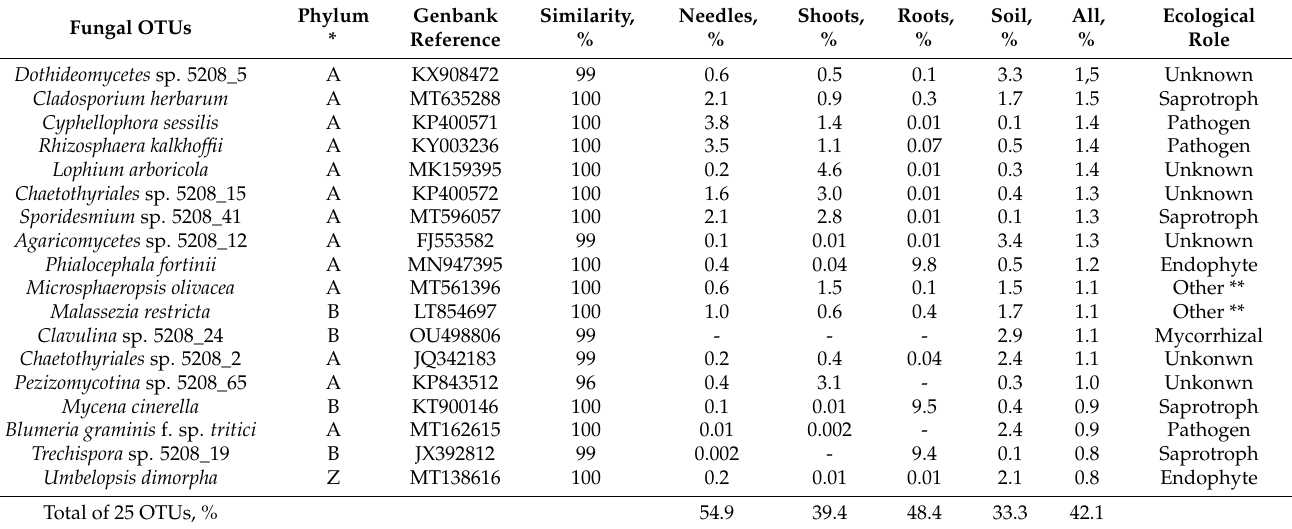
The relative abundance of most common plant pathogenic fungal OTUs is shown in Table 4. Plant pathogens were found to be most abundant in needles (9.7%) and soil (6.7%), when in shoots (4.6%), and these were least common in the roots (0.2%). In needles, the most common plant pathogens were C. sessilis (3.8%) and R. kalkhoffii (3.5%), in the soil— P. lacerum (3.8%) and Microsphaeropsis olivacea (1.5%), in shoots— M. olivacea (1.5%) and C.